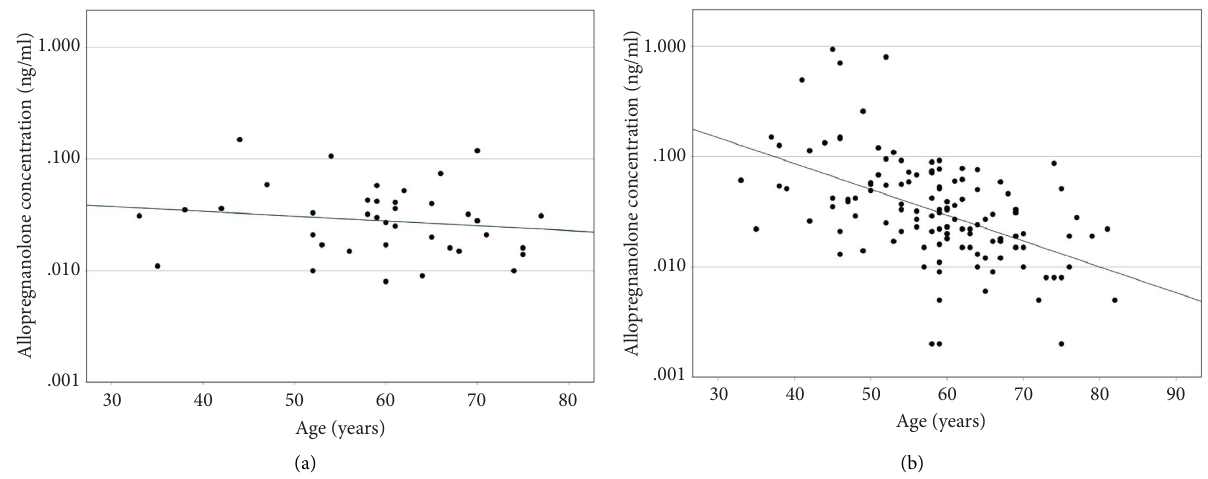
Figure 1: Serum allopregnanolone levels (ng/ml) according to age (years) (a) healthy cohort and (b) PBC